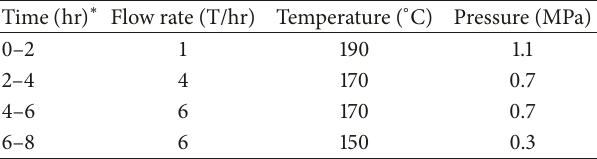
Figure 4: Mass flow rates of Case 3. Table 2: Precooling injection in Case